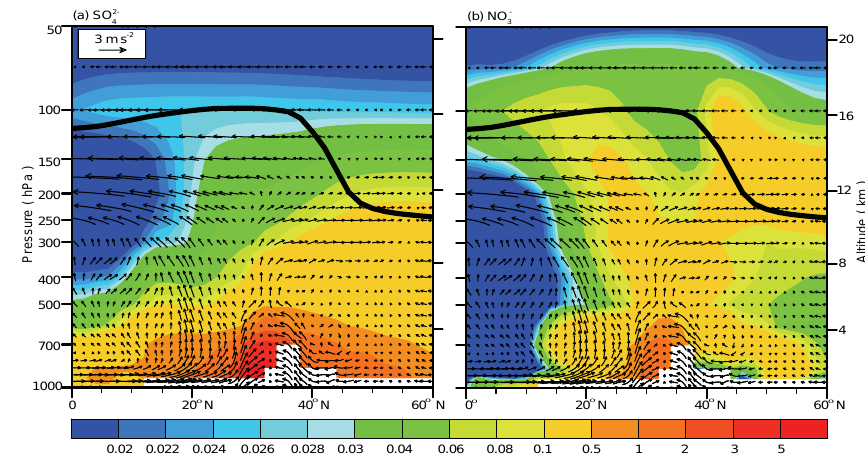
Figure 11. Latitude–altitude cross sections of simulated concentrations (color shades, µgm − 3 ) of SO 2 − in June–August of 2005, together with the wind vectors obtained from the European Centre for Medium-Range Weather Forecasts (ECMWF) ERA-Interim Reanalysis data. The black line denotes the tropopause simulated by the GEOS-Chem model.